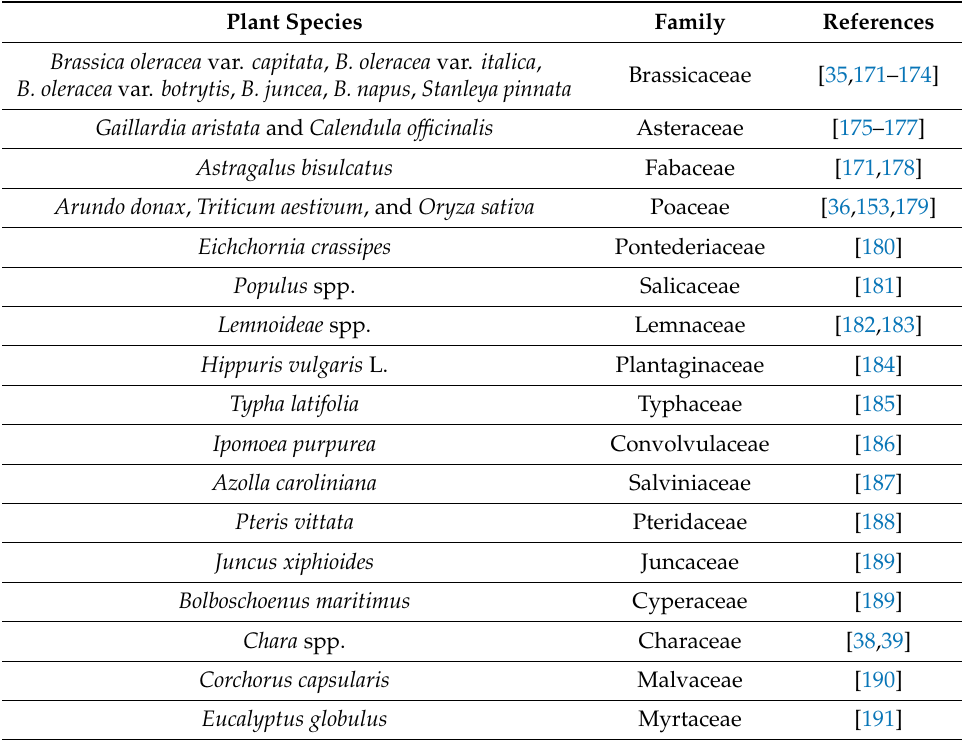
Table 3. List of selected plant species used for Se